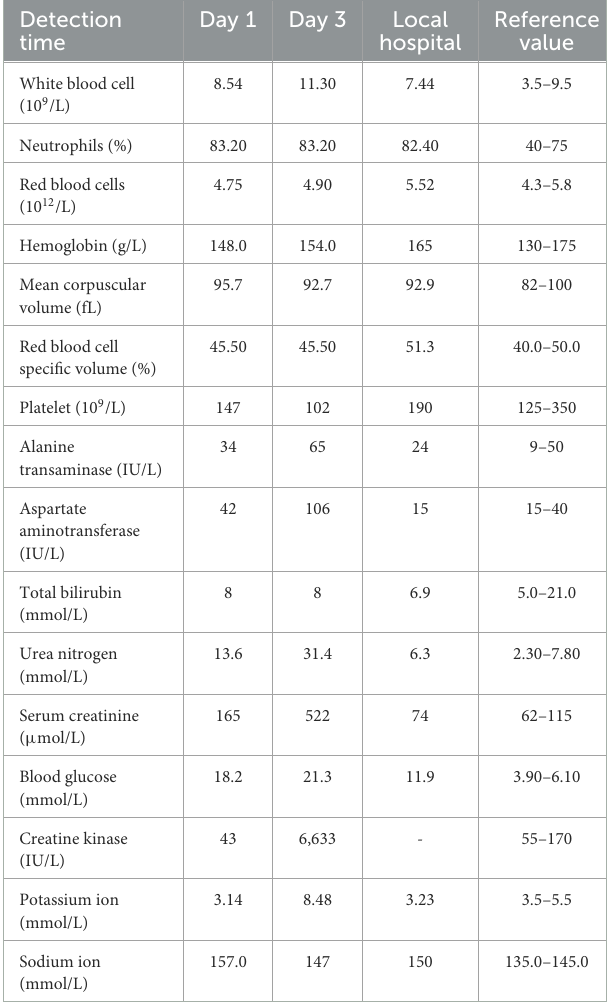
TABLE 1 Results of various laboratory tests before and after